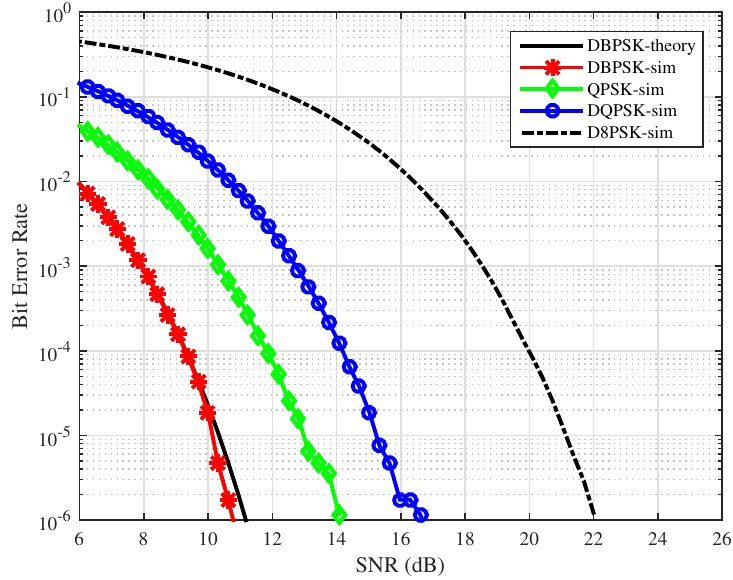
Figure 12. System Bit Error Rate (BER) performance as a function of Signal to Noise Ratio (SNR).